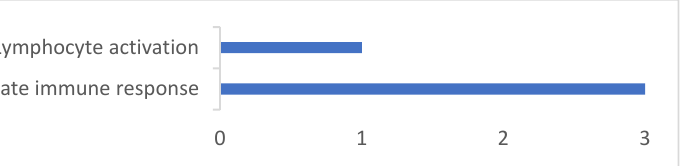
Figure 9. Total number of immune system processes of candidate genes identified with GWAS for logFEC using 170 SNPs and the 507 and 50K SNP chips.